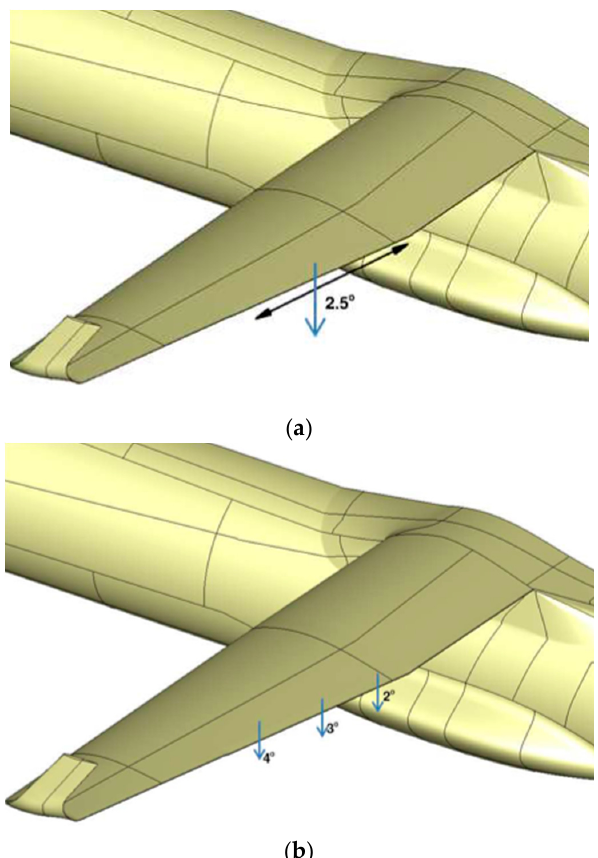
Figure 2. Configurations for the multifunctional TE: ( a ) Trailing-edge rigid rotation (Mode A) equal to 2.5°; ( b ) Continuous increase in deflection angles (Mode B) from tip to root (4°/3°/2°).